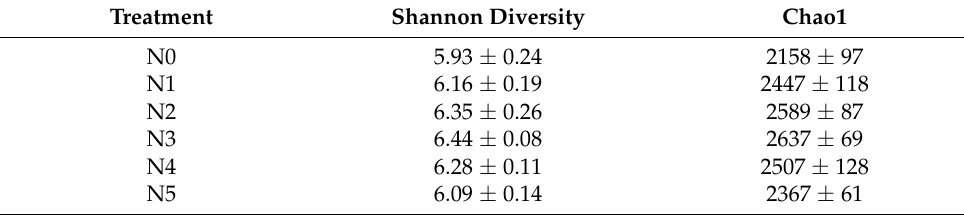
Figure 2. Physiochemical properties of the soil in different nitrogen fertilization treatments. Different letters indicate significant differences at p < 0.05 level (ANOVA). ( A ) soil pH, the content of ( B ) TOM, ( C ) TN, ( D ) AN, ( E ) NH 4+ -N, ( F ) NO 3- -N, ( G ) TP, ( H ) AP, ( I ) TK and ( J ) AK in the orchard soil. Table 1. Soil bacterial α -diversity indexes in different nitrogen fertilization